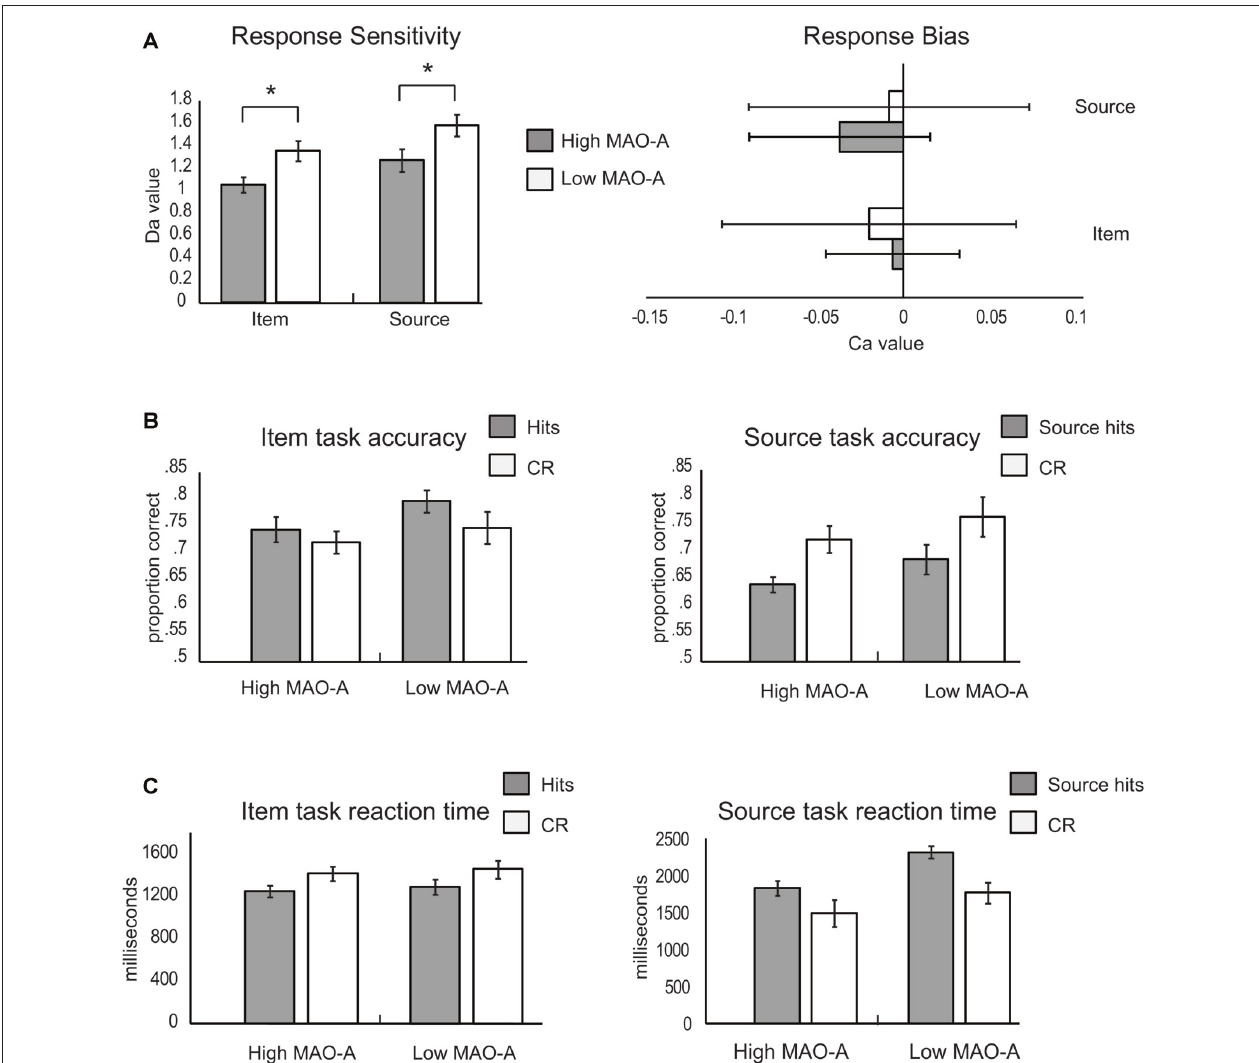
FIGURE 3 | Item and source memory results. (A) Response sensitivity (left) and response bias (right) during the item and source memory tasks. High monoamine oxidase A (MAO-A) groups are represented by light gray bars and Low MAO-A groups by white bars. Response sensitivity (left panel) was lower in the High MAO-A groups during both item and source memory. There was no difference in response bias (right panel) between groups. (B) Item (left) and source (right) memory accuracy. The left graph illustrates the proportion of responses where a previously presented item was successfully identified as old (hits; gray) and where new items were successfully classified as new (correct rejections, CR, white) for High and Low MAO-A groups during item memory. No differences in accuracy were observed between groups during item memory. The right graph illustrates proportions correct during source memory. The gray bars represent the proportion of trials